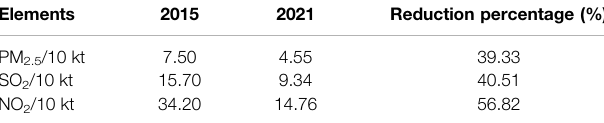
TABLE 5 | Pollutant emission in Tianjin in 2015 and